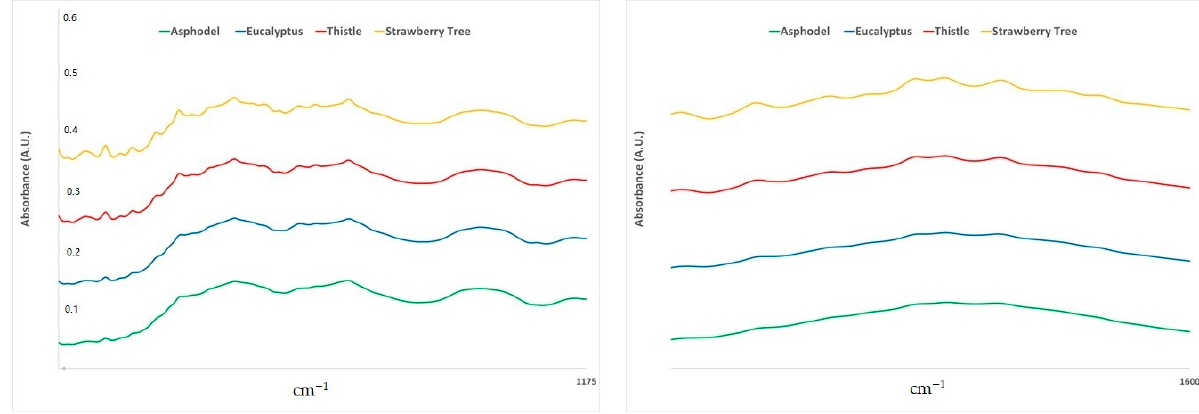
Figure 2. Average ATR-FTIR spectra in the 1540–1175 cm − 1 (left) and 1700–1600 cm − 1 (right) regions. As a mere visualization aid, an unsupervised (i.e., with no classification and/or re- gression aims) random forest was performed and plotted after multidimensional scaling (MDS, Figure 3).